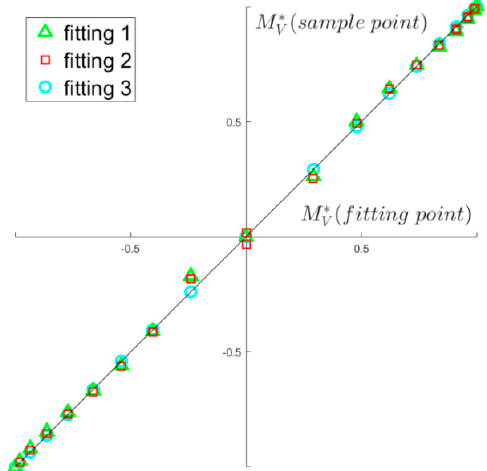
Figure 21. The case of an intact hull.